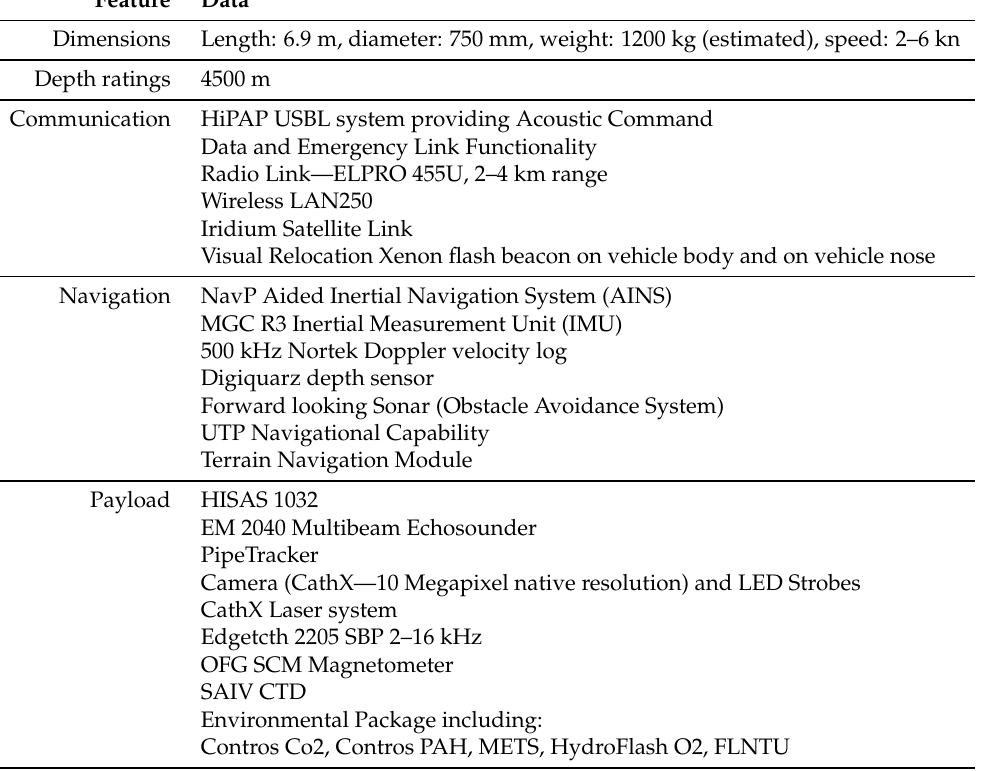
Table 1. Specifications of Kongsberg Maritime HUGIN AUV ‘Rental 1’, used for the high-resolution bathymetric and imagery data collection during the final survey in Kalamata,